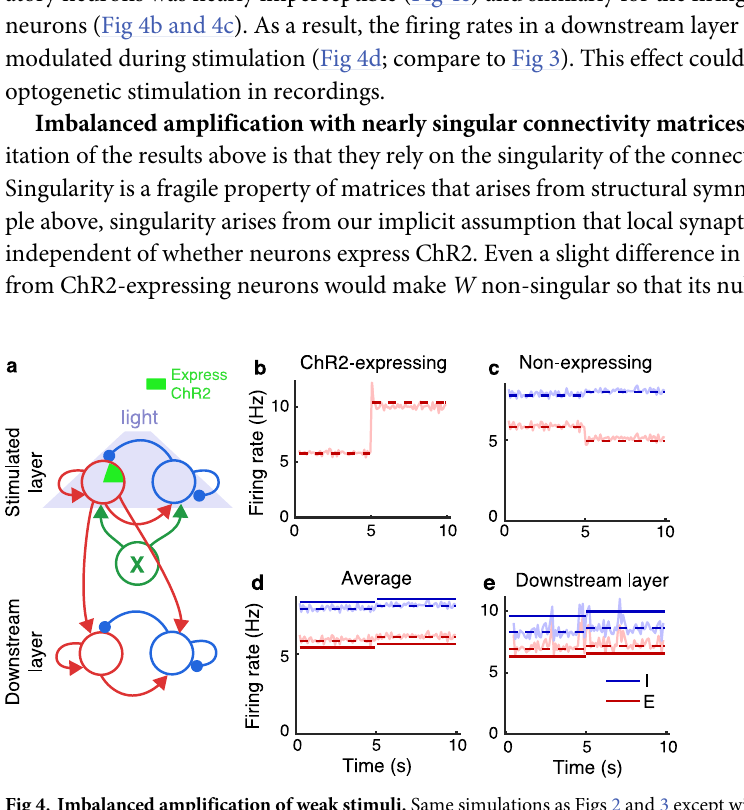
Fig 4. Imbalanced amplification of weak stimuli. Same simulations as Figs 2 and 3 except with N increased by a factor of four, (cid:15) decreased by a factor of two, and a weaker stimulus. a) Schematic. A recurrent network (stimulated layer), which receives external input from Poisson-spiking neurons (green X) and from partial optogenetic stimulation, sends excitatory synaptic input to an identical network (downstream layer). b) Average firing rate of ChR2-expressing excitatory neurons in the stimulated layer from simulations (light solid) and from the corrected approximation (Eq (4); dashed). c) Same as b, but for non-expressing excitatory (red) and inhibitory (blue) neurons in the stimulated layer. d) Same as b, but averaged over all excitatory neurons in the stimulated layer. e) Same as d, but for the downstream layer. Mean firing rates from simulations of the stimulated layer changed from 5.8 Hz before stimulation to 10.0 Hz during stimulation for ChR2-expressing neurons, from 5.9 to 5.1 Hz for non-expressing excitatory neurons, from 5.9 to 6.1 Hz averaged over all excitatory neurons, and from 7.8 to 8.0 Hz for inhibitory neurons. Mean firing rates from simulations of the downstream layer changed from 7.2 Hz to 8.1 Hz for excitatory neurons and from 8.5 Hz to 9.5 Hz for inhibitory